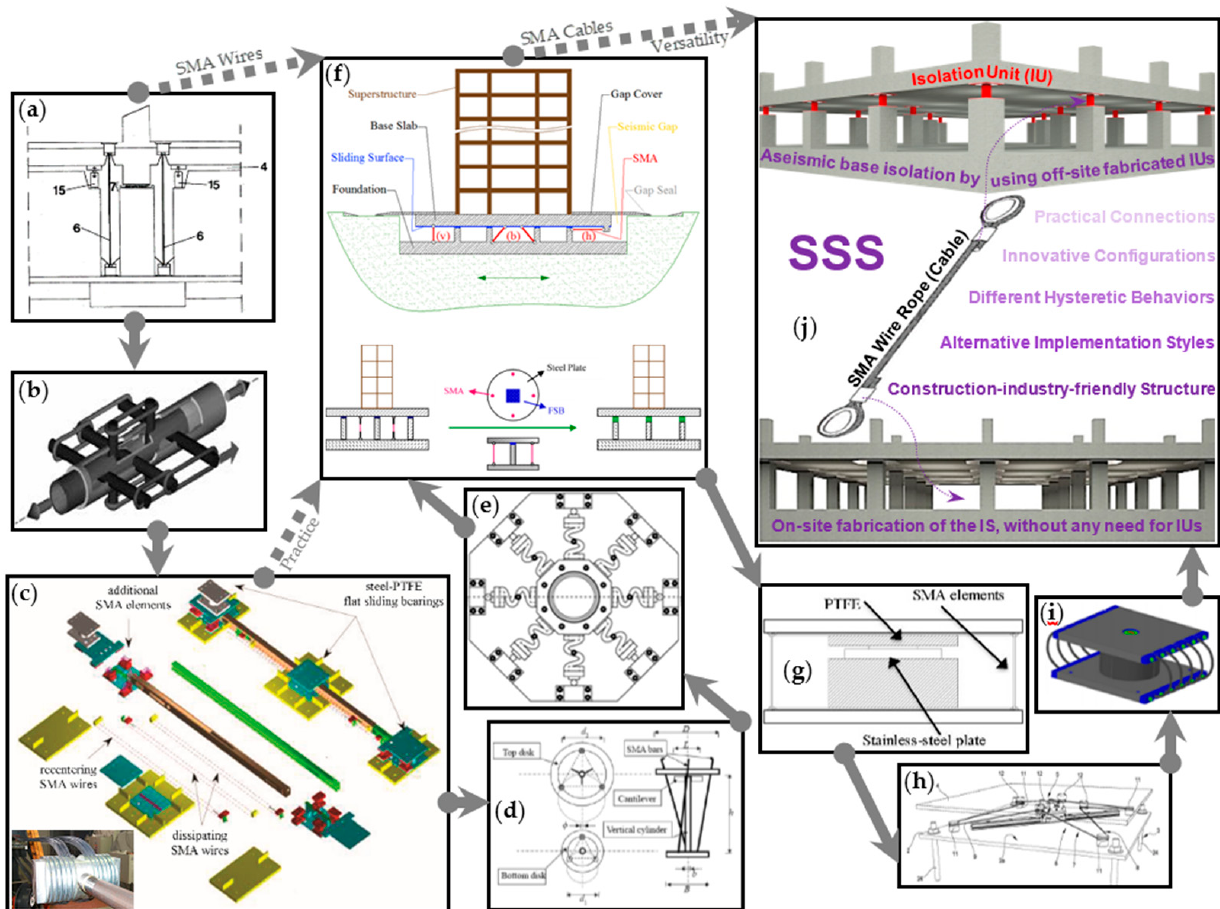
Figure 2. The history of SMA-based sliding ISs: ( a ) Logiadis et al. in 1997 [38]; ( b ) Dolce et al. in 2000 [41]; ( c ) Cardone et al. in 2003 [44]; ( d ) Casciati et al. in 2007 [45]; ( e ) Attanasi et al. in 2008 [46]; ( f ) Cardone et al. in 2009 [48]; ( g ) Ozbulut and Silwal 2014 [54]; ( h ) Colato and Castellano in 2015 [55]; ( i ) Zheng and Dong in 2017 [59]; ( j ) Narjabadifam et al. in 2020 [69].